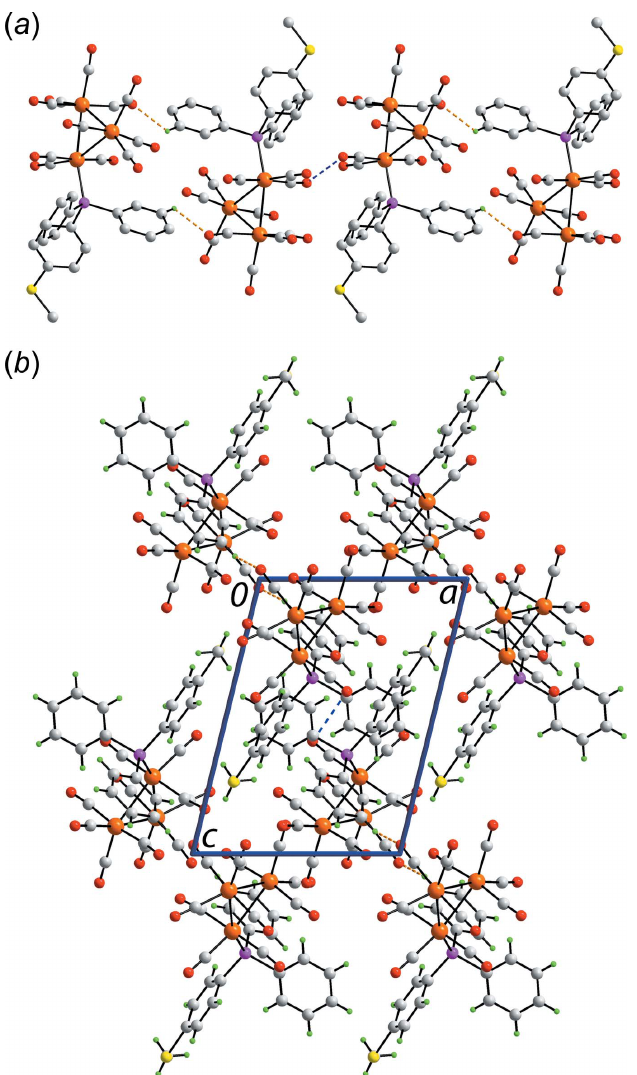
Figure 2 Molecular packing in (I): ( a ) The supramolecular chain sustained by C— H (cid:2)(cid:2)(cid:2) O and O (cid:2)(cid:2)(cid:2) O interactions and ( b ) a view of the unit-cell contents shown in projection down the b axis. The C—H (cid:2)(cid:2)(cid:2) O and O (cid:2)(cid:2)(cid:2) O interactions are shown as orange and blue dashed lines, respectively.